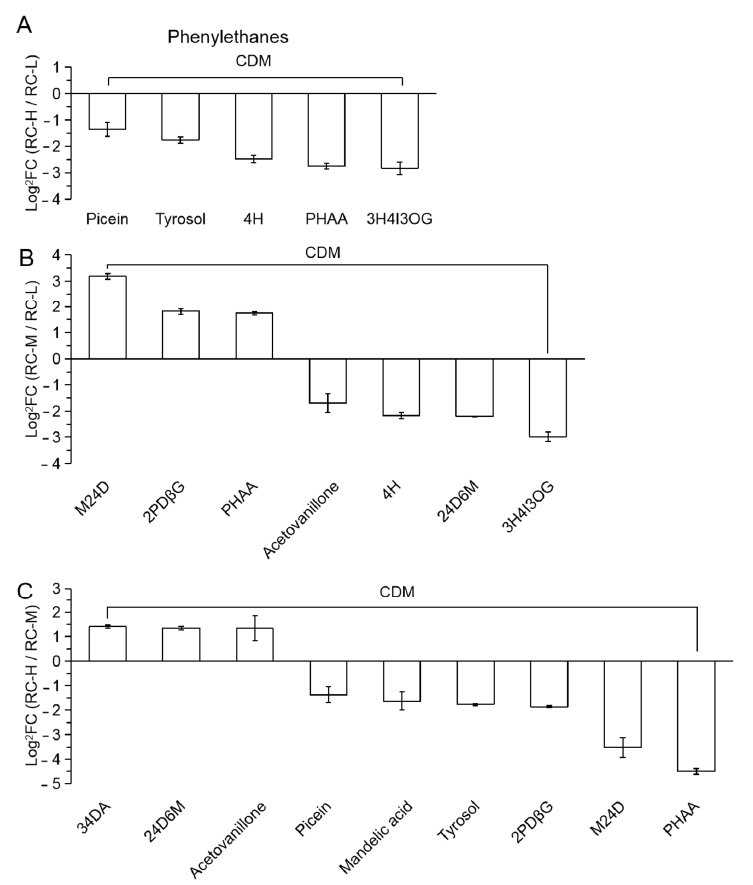
Figure 14. Comparison of differential metabolites of phenylethanes between RC-L, RC-M and RC-H. These were 5 CDMs for RC-H vs. RC-L ( A ), 7 CDMs for RC-M vs. RC-L ( B ), and 9 CDMs for RC-H vs. RC-M ( C ). Upregulation denotes that the content of a metabolite in RC increased with elevation between two altitudes, and the opposite for downregulation. The Y-axis is shown as Log 2 FC values for the convenience of visual presentation (Note: The up-amplitude in the text refers to the FC value). The X-axis denotes metabolite